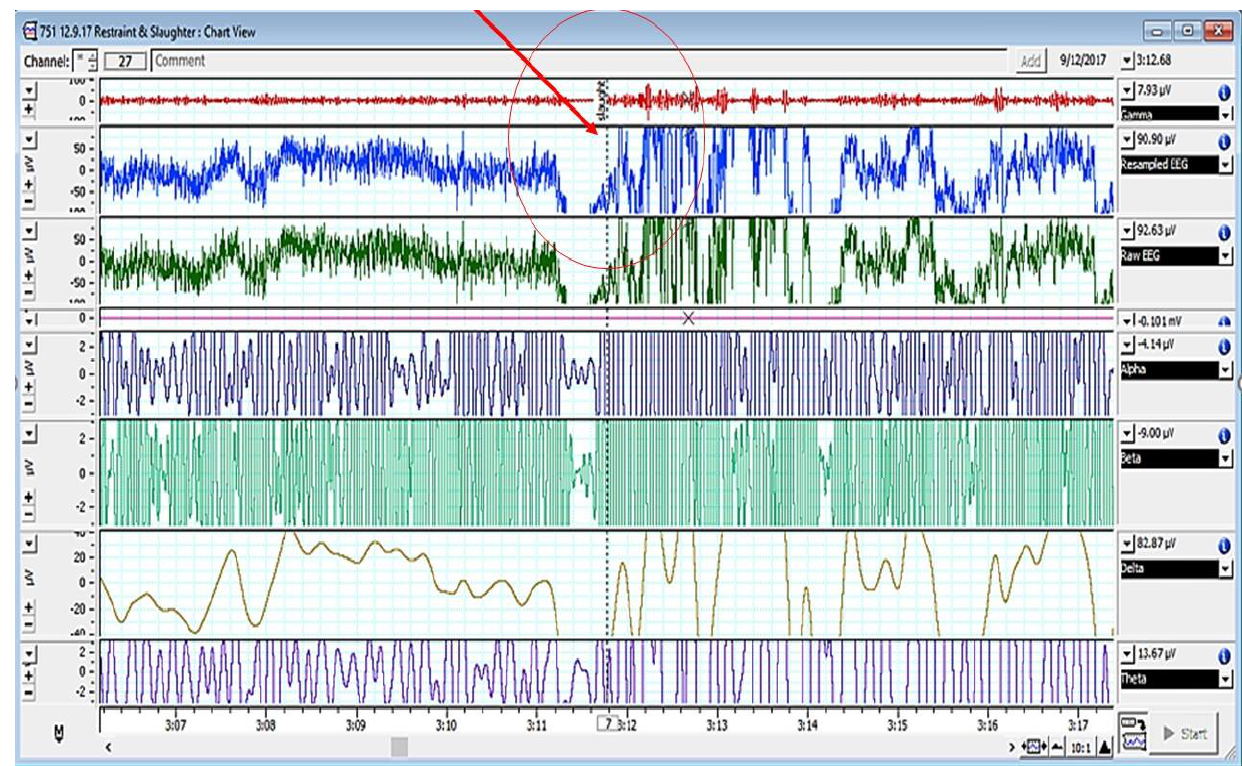
Figure 4. EEG spectrum of cattle pre- and post-slaughter (encircled/red arrow showing the point of slaughter).